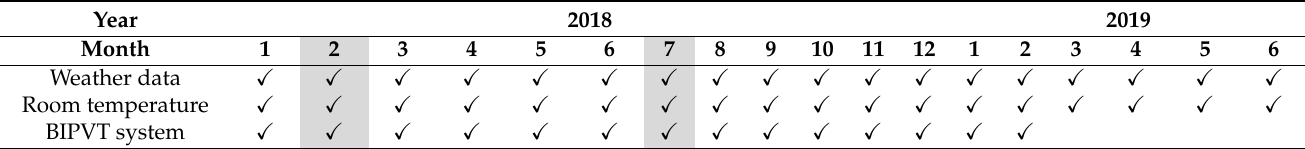
Table 3. Recording periods for each observed